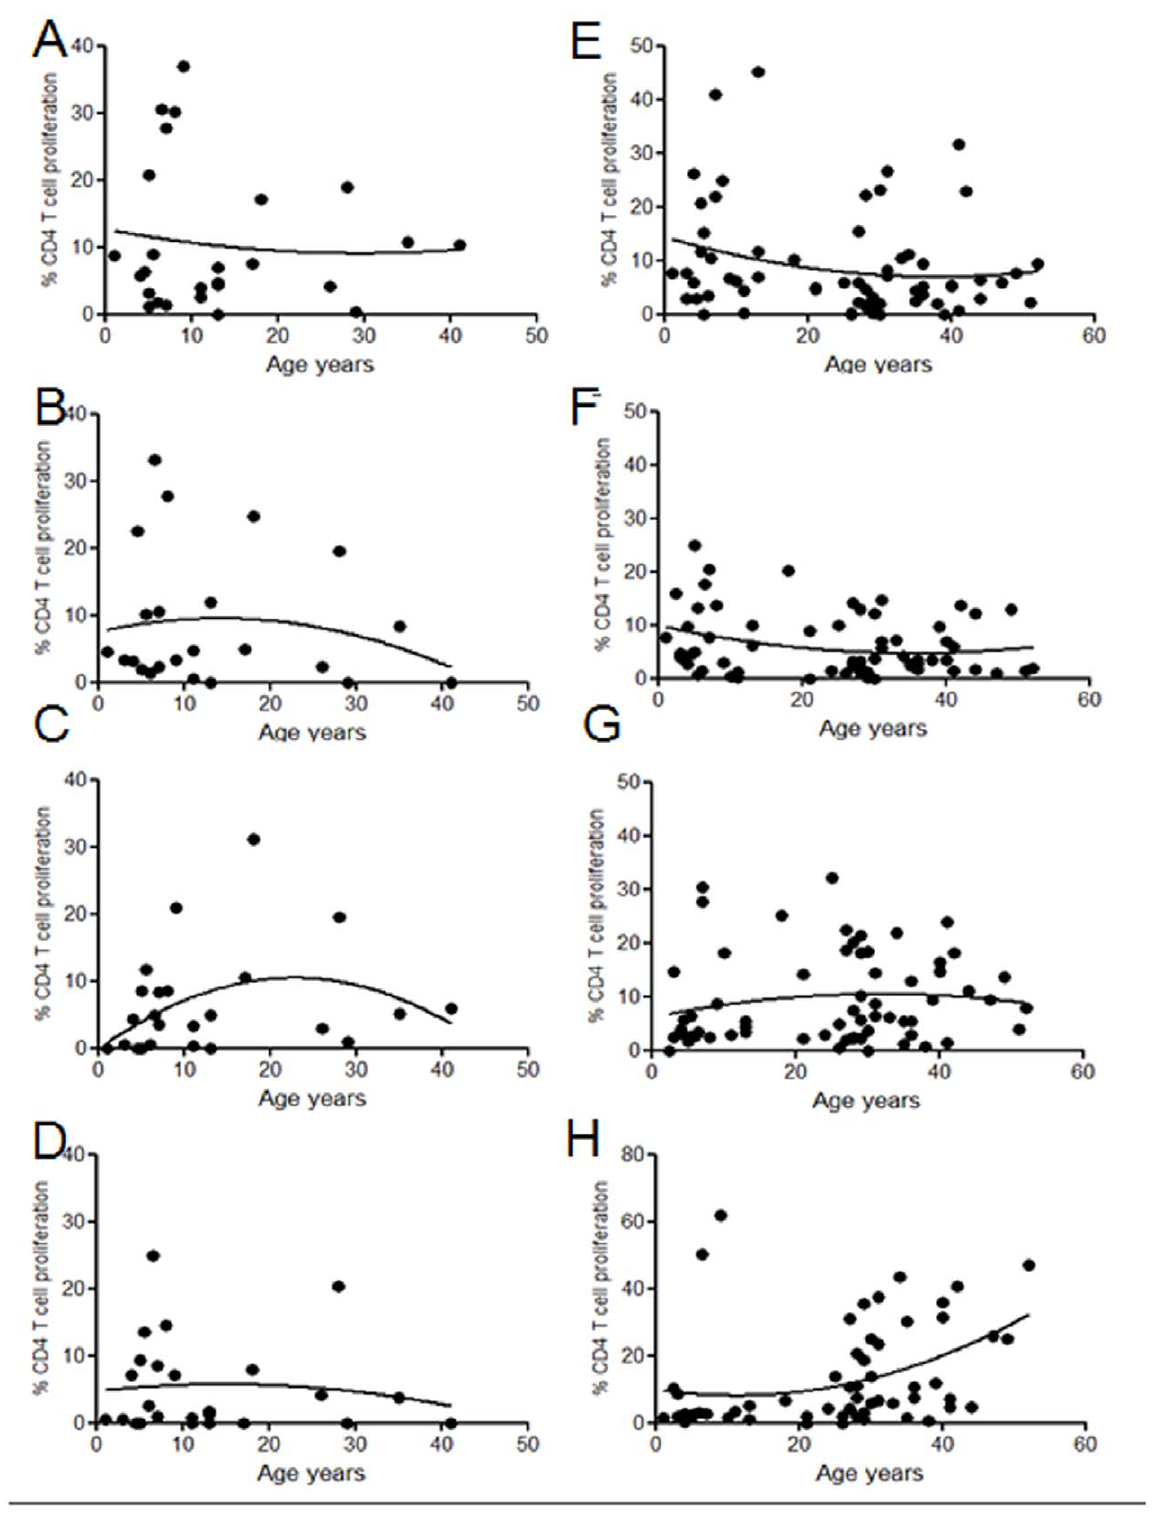
Figure 1. Mucosal and peripheral blood CD4 T cell responses to pneumococcal, influenza and MTB-PPD antigens in Malawian children and adults. Mucosal CD4 T cell proliferation in response to pneumoCCS n=26 ( a ) and Ply-CCS n=24 ( b ) influenza n=25 ( c ) and MTB n=25 ( d ) in children and adults. Circulating CD4 T cell proliferation in response to pneumoCCS n=66 ( e ), Ply-CCS n=67 ( f ), influenza n=65 ( g ) and MTB-PPD n=58 ( h ) in children and adults. Data was analyzed by nonlinear regression modeling, fitted with second order polynomial.